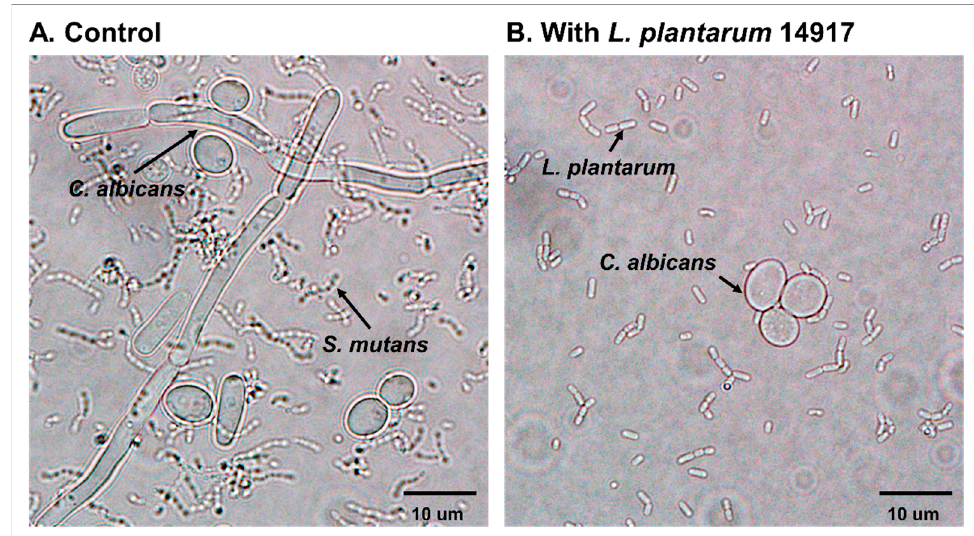
Figure 2. Inhibition of C. albicans hypha formation by L. plantarum 14917. ( A ) S. mutans and C. albicans grown in 1% glucose at 24 h. ( B ) S. mutans and C. albicans grown in 1% glucose with added L. plantarum 14917 at 24 h.